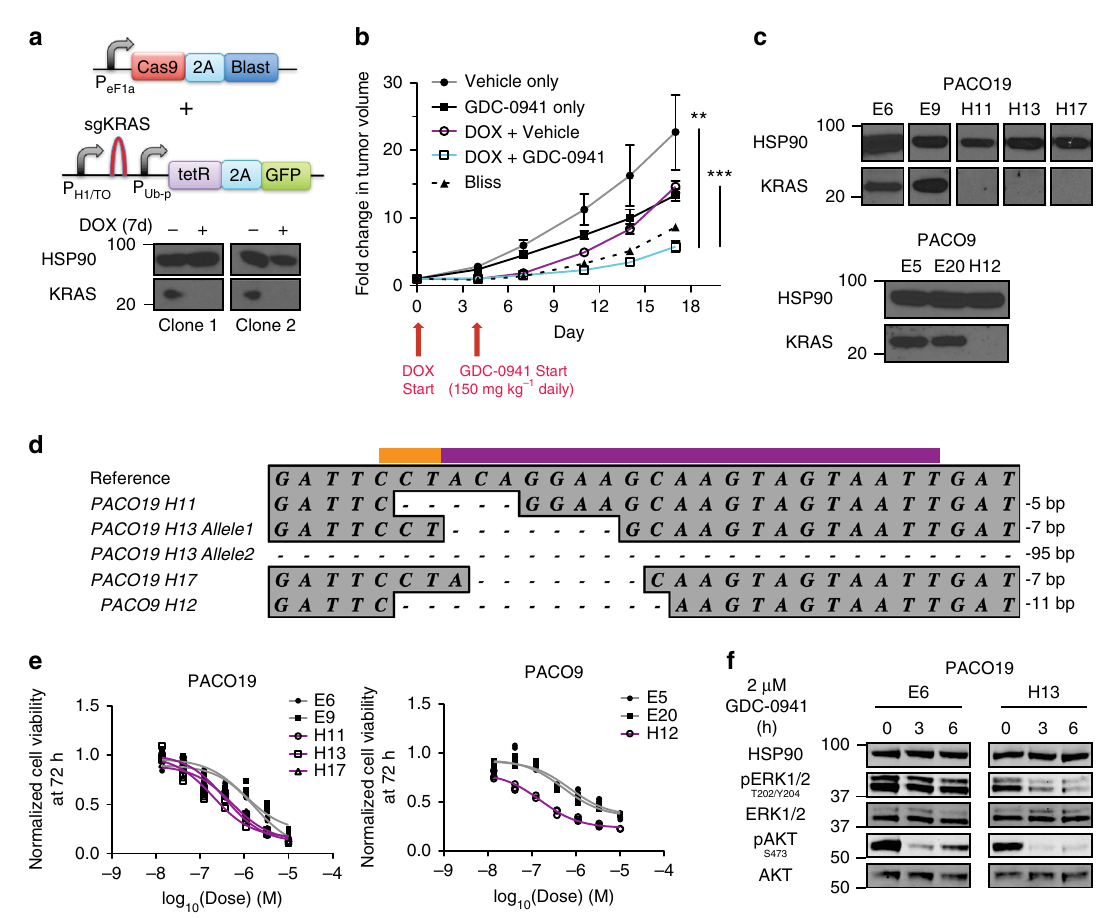
Fig. 7 Combined KRAS and PI3K inhibition as a therapeutic approach in PDAC cells. a Schematic of lentiviral constructs to express Cas9 and a doxycycline (DOX)-inducible sgRNA targeting KRAS (sgKRAS). P eF1a ubiquitously expressed elongation factor 1a promoter. 2A self-cleaving peptide. Blast blasticidin resistance gene. TRE tetracycline-responsive element. P H1/TO H1 promoter with Tet-operator sites. P Ub-P ubiquitin promoter. tetR Tet-repressor. DOX treatment relieves tetR repression of H1 promoter to permit sgKRAS expression. Western blot showed complete KRAS protein ablation in two different A13 mmKras . 366 clones after 7 days of DOX treatment in vitro. b Combined KRAS (by DOX-inducible mmKras . 366 ) and PI3K (by GDC-0941) inhibition in established subcutaneous tumors effectively inhibited tumor growth, whereas inhibition of KRAS or PI3K alone was insuf fi cient to suppress tumor growth long term. Average tumor volume fold increase (normalized to start of DOX treatment, pooled for both clones in a ) ± s.e.m. ( n = 10 tumors per group) is plotted. Dashed line denotes bliss independence for additive effect of DOX and GDC-0941, consistent with synergism starting at day 11. ** p < 0.01, two- tailed Student ’ s t test, DOX + GDC-0941 vs. Vehicle only at end of experiment. *** p < 0.001, two-tailed Student ’ s t test, DOX + GDC-0941 vs. DOX + Vehicle at end of experiment. c Western blot con fi rmed loss of KRAS protein in knockout clones derived from PACO19 (H11, H13, H17) and PACO9 (H12) compared to intact clones (PACO19-E6,E9; PACO9-E5,E20). HSP90 is loading control. d KRAS alleles from PACO19 and PACO9 clones showed out-of- frame indels in KRAS de fi cient clones. Reference corresponds to UCSC hg19 sequence. All clones retained a single indel allele except for PACO19 H13 for which two different indels were identi fi ed, one of which was a 95 bp deletion that is not pictured in full. The purple and orange bars denote the sgRNA and PAM sequences, respectively. e Dose-response curves of PACO19 and PACO9 KRAS intact (gray) and de fi cient (purple) clones to the pan-PI3K inhibitor GDC-0941. Each replicate ( n = 3 for each dose) and curve fi t are shown. f Western blot showed a decrease in pERK1/2 levels in KRAS de fi cient (H13) but not intact (E6) clones derived from PACO19 cells following GDC-0941